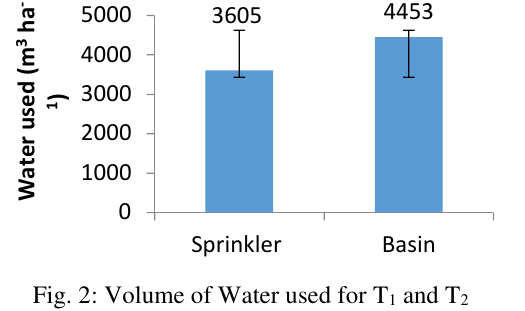
Fig. 2: Volume of Water used for T 1 and T 2 treatments